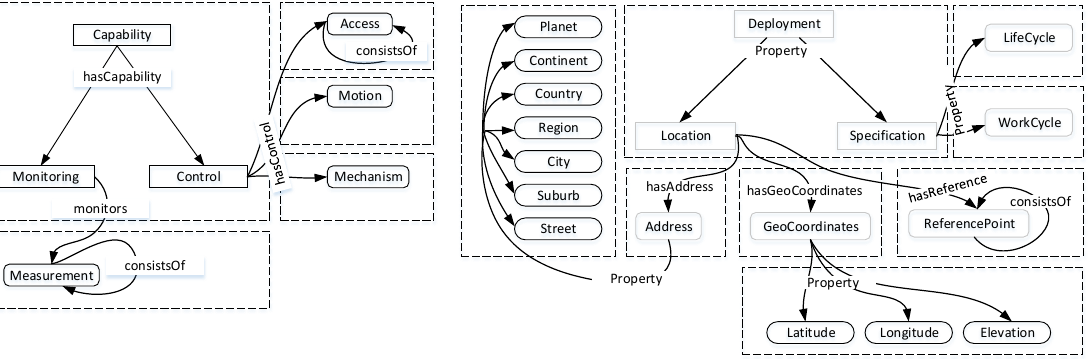
Figure 3. Capability and deployment